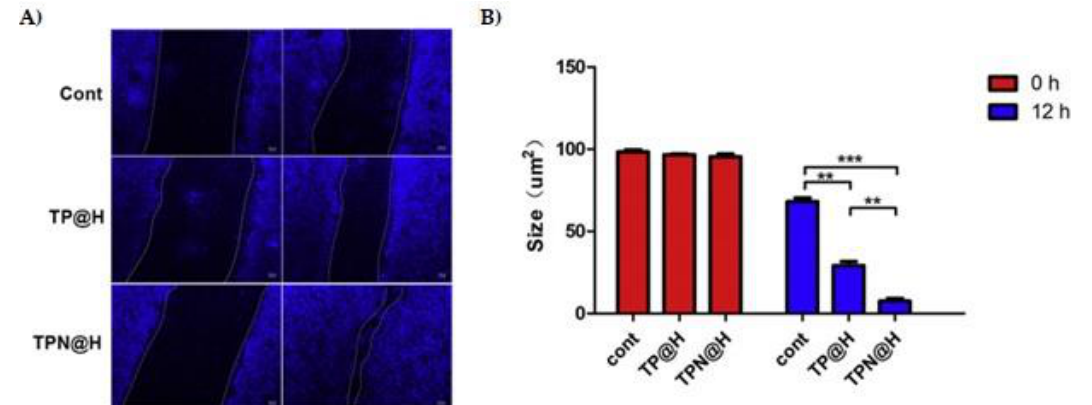
Figure 8. Cells-scratch wound healing in vitro assay. ( A ) Effects of TP@H (Hydrogel containing green tea polyphenol non-encapsulated) and TPN@H (Hydrogel containing green tea polyphenol-loaded nanospheres) on the migration of fibroblasts HFF-1 cells - Scale bar: 500 μm. ( B ) Quantitative analysis of the migration rates in ( A ). The blue fluorescence showed the nucleus, stained with DAPI The asterisks denote statistic differences with p -value p < 0.01 (**) or p < 0.001 (***). Figure reproduced with permission from Chen and co-workers [79].